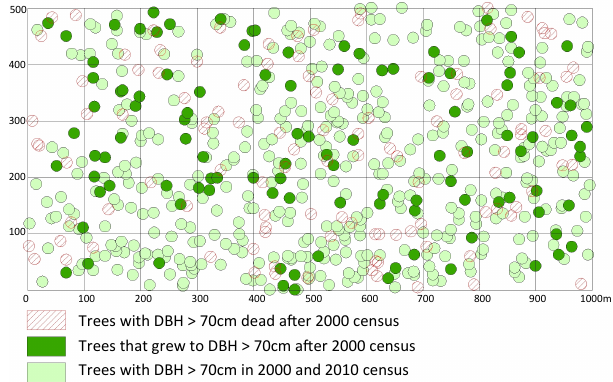
Fig. 10. Dynamics of big trees (DBH > 70cm) in the 50ha plot between 2000 and 2010. A total of 109 big trees died between 2000 and 2010, while 107 trees entered that DBH class during that time.